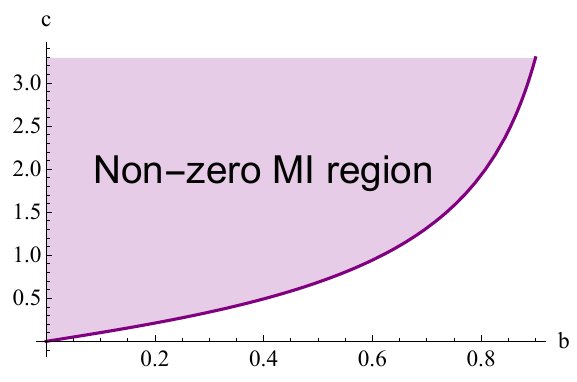
Figure 6 . The purple shaded region is the configuration space with non-zero MI for AdS 4 .